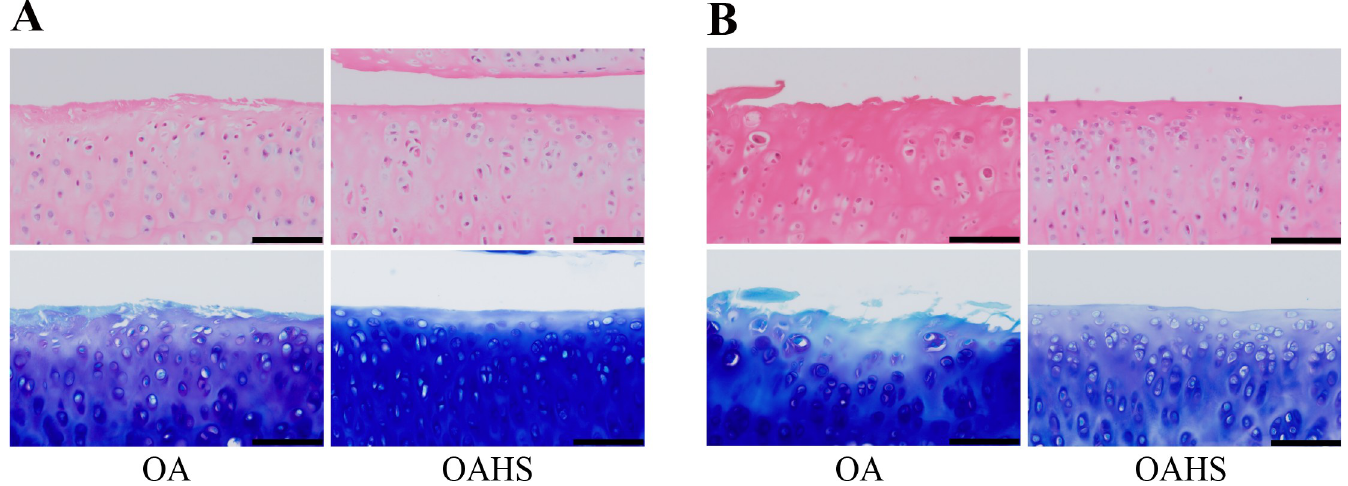
Fig 3. Histological findings of the tibial articular cartilage at a high magnification. (A) and (B) represent histological images at 2 and 4 weeks, respectively. In the OA group, fibrillation was detected at 2 weeks, and a moderate decrease in toluidine blue staining intensity was found from the surface to the middle layer. At 4 weeks, fibrillation and fissures were detected, and the staining intensity was further decreased. In the OAHS group, the articular surface was intact at both 2 and 4 weeks, but the overall staining intensity was slightly reduced. Scale bar = 100 μ m.